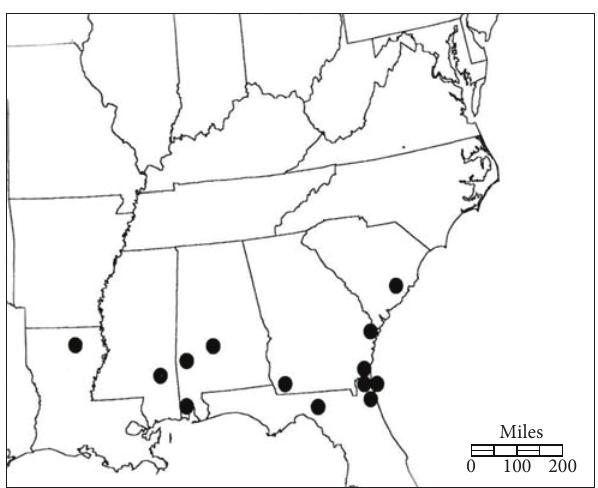
F 1: Locations for Hardwood Research Cooperative’s eucalyptus evaluation